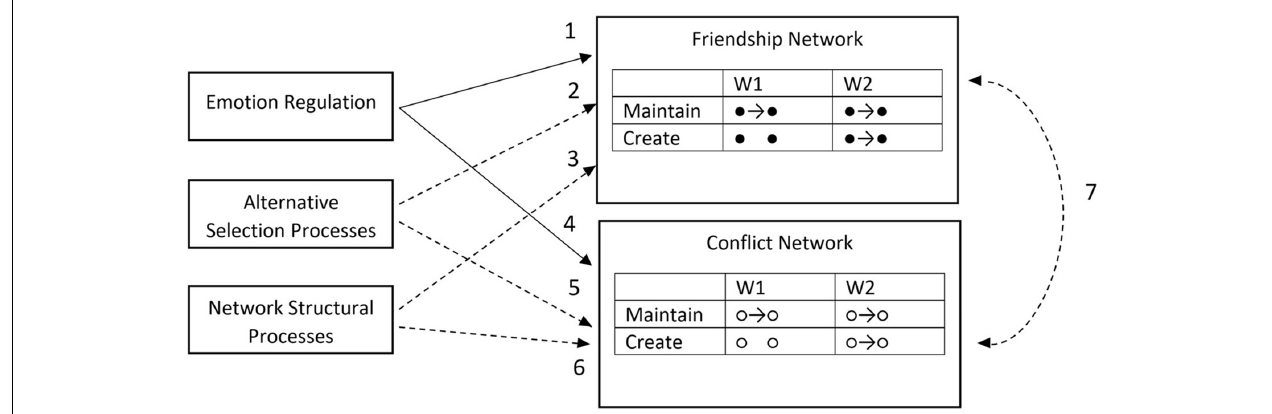
FIGURE 1 | Conceptual diagram of how emotion regulation contributes to friendship and conflict network selection dynamics in social groups. Paths are numbered in the order they are discussed in the text. Solid lines represent the main paths of interest examined in this study; dashed lines represent paths describing alternative social network selection processes that we statiscally account for by simulataneous inclusion in our model.